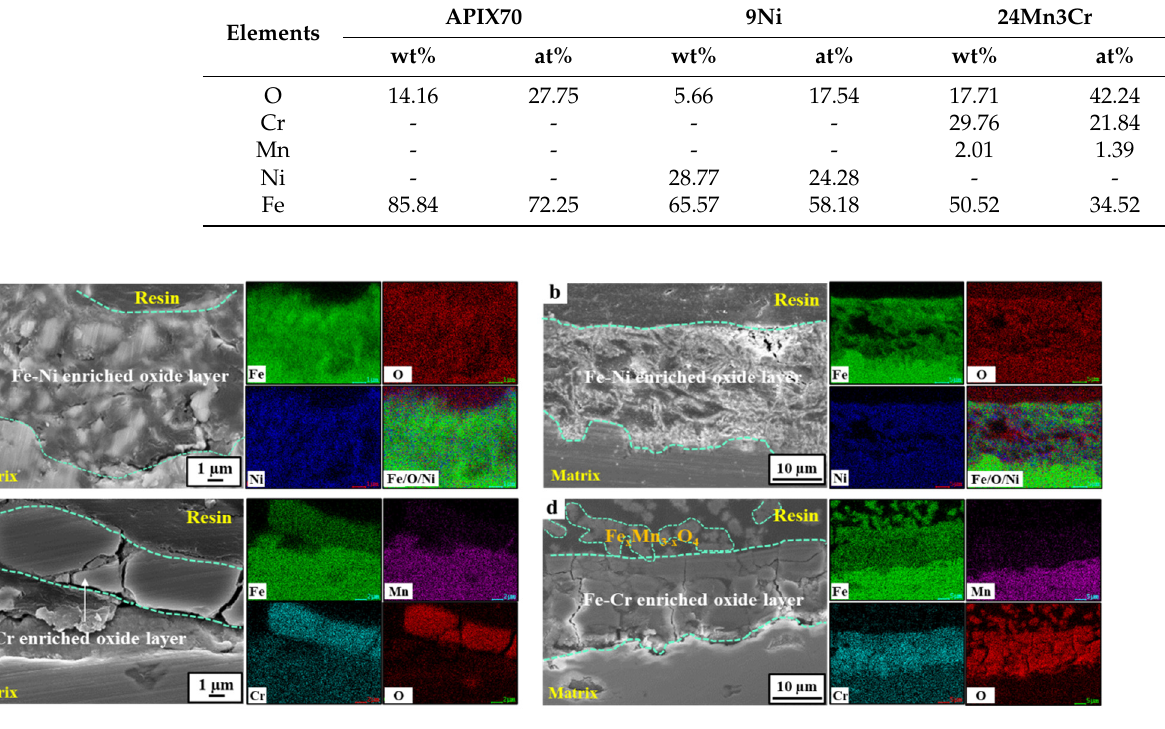
Figure 7. EDS mapping of a cross-section of the tested samples with different immersion times. ( a ) and ( b ) 9Ni sample immersed for 7 and 28 days, respectively; ( c , d ) 24Mn3Cr sample immersed for 7 and 28 days, respectively.